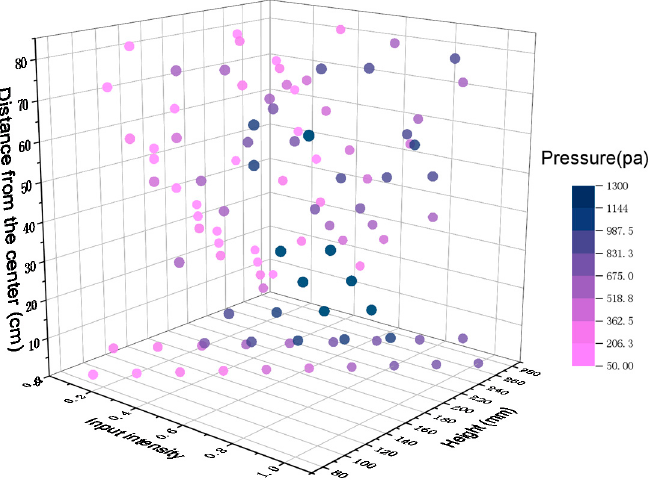
Figure 10. Three-dimensional display of test data points. The x -axis is the intensity of the input command, the y -axis is the height, the z -axis is the distance from the centre point, the test points are characteristic data points of different parameter combinations, and the measured pressure is indicated by color.